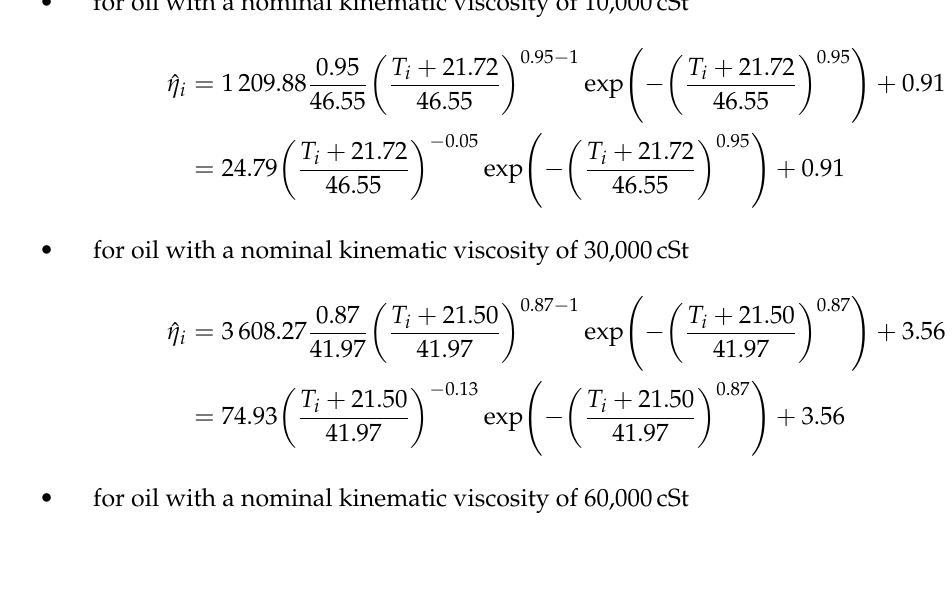
Table 2. The determined parameters can be used to derive the following analytical formulas for the viscosity of the tested oils as a function of